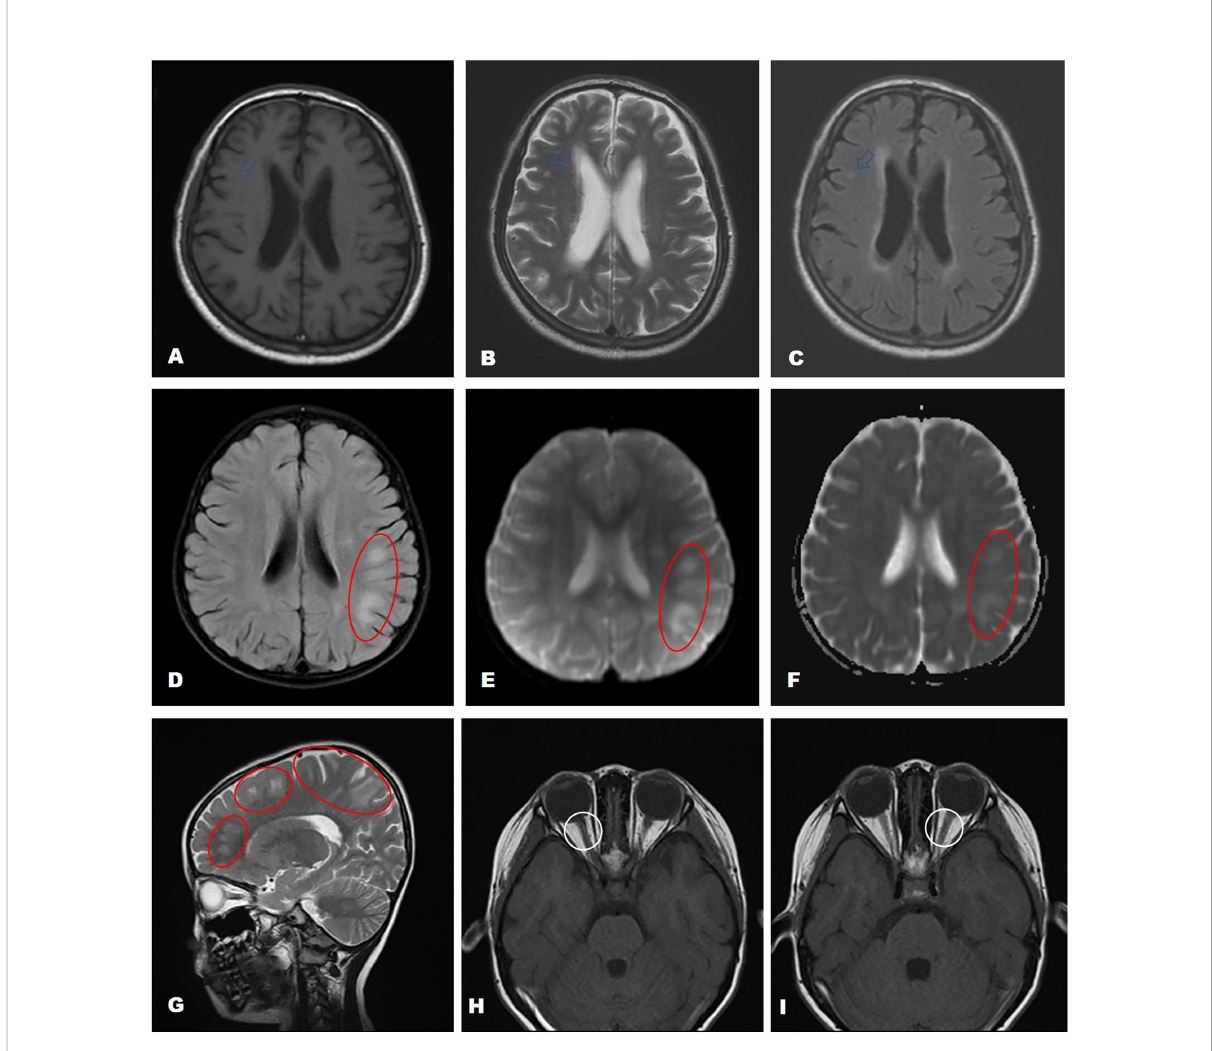
FIGURE 4 MRI fi ndings of AE patients with coexisting antibodies. The brain MRI of Patient 18 showed a small patchy area with long T1 and long T2 signal shadows in the right frontal lobe with a high T2-FLAIR signal ( A – C , marked by a red circle and a white arrow). Patient 19 showed multiple demyelinating lesions in the white matter of the left cerebral hemisphere ( D – G , marked by a red circle) and the bilateral optic nerve H , I Fat suppression-T2